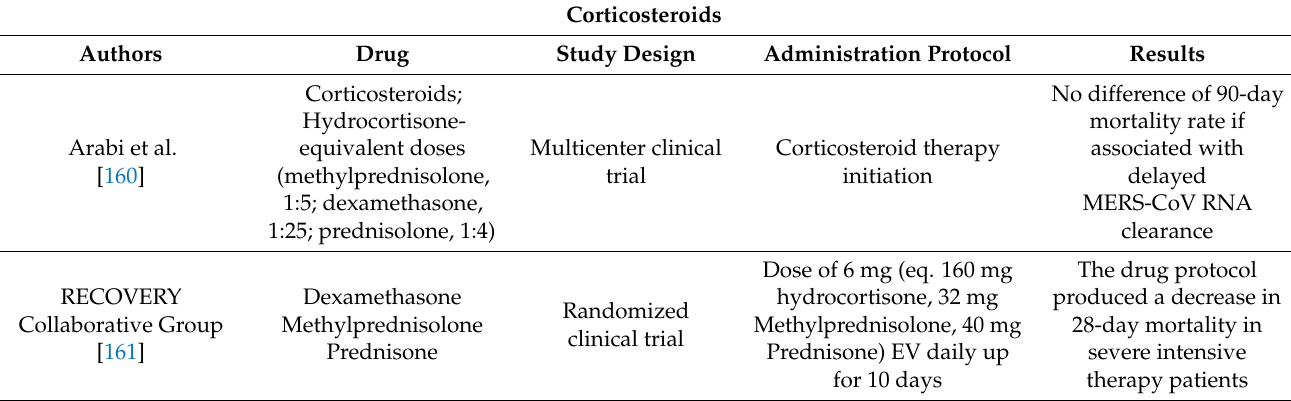
Table 6. Summary of the in vivo studies included about corticosteroid treatments for viral infections.